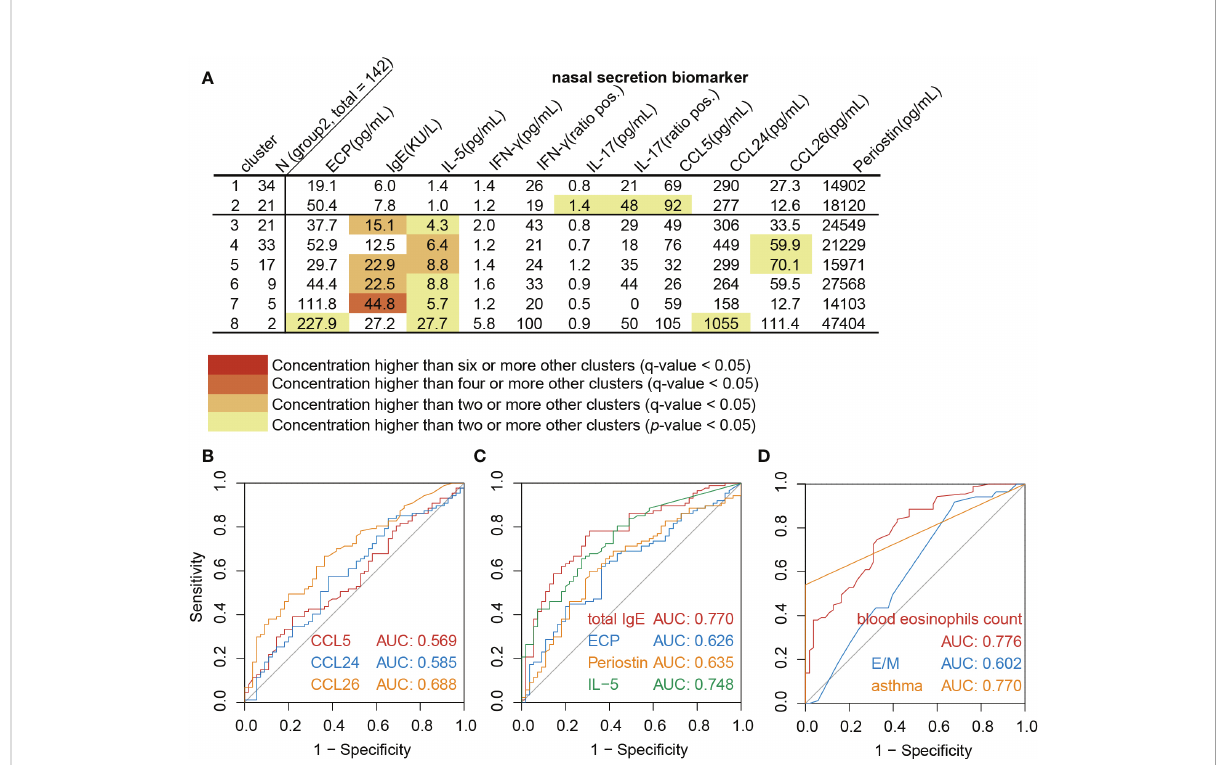
FIGURE 3 NasSec and clinic markers for diagnosis of Th2 high CRSwNP. (A) . Modi fi ed heat map of biomarkers in nasal secretions from each cluster (Group 2, n = 142). (B-D) . Receiver operating characteristic curve (ROC) analysis for prediction of Th2 high CRSwNP (Group 2, n = 142). AUC: area under ROC curve; E/M: ratio of Lund-Mackay scores for the ethmoid sinus and maxillary sinus.